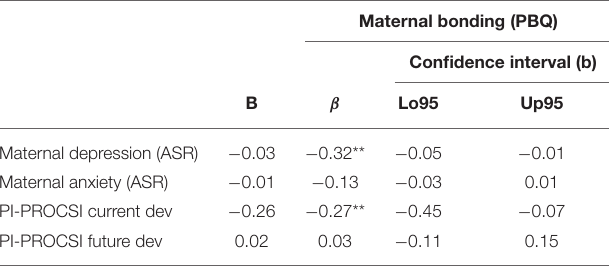
TABLE 2 | Regression of maternal bonding on PI-PROCSI current and future development, maternal depression and anxiety ( N = 129). Maternal bonding